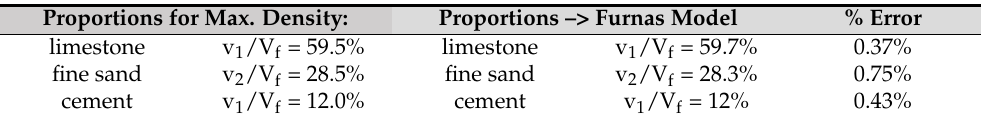
Table 3. Furnas model vs. our model. Proportions for Max.